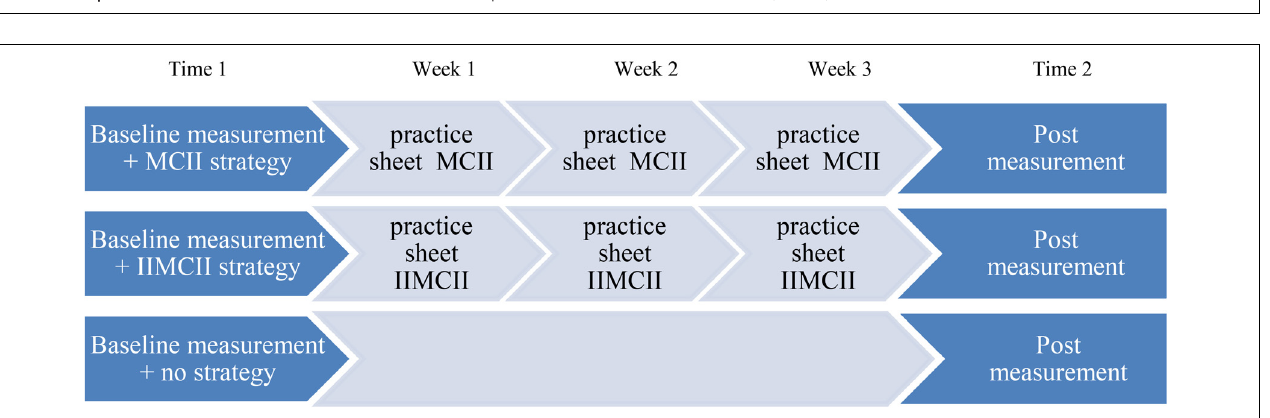
FIGURE 3 | Time line of the course of events in the three conditions: MCII, IIMCII, and control.